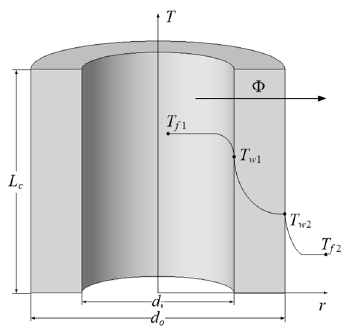
Figure 2. Heat transfer process in the